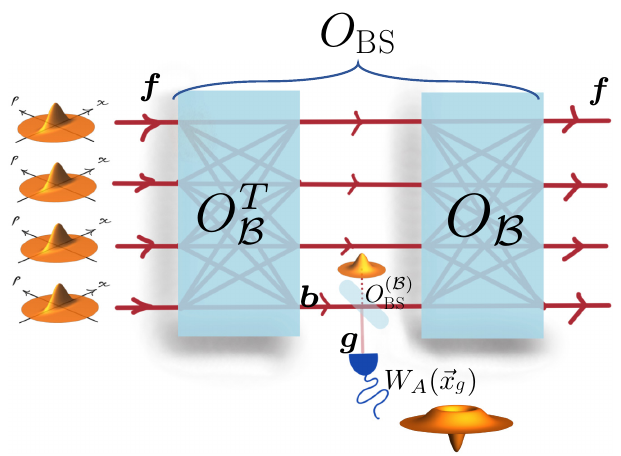
FIG. 4. Schematic representation of an implementation of mode-selective photon subtraction. See main text for details. For illustration, the initial state on the left is a product of single- mode squeezed vacuum states, but the protocol can in principle be applied to any Gaussian